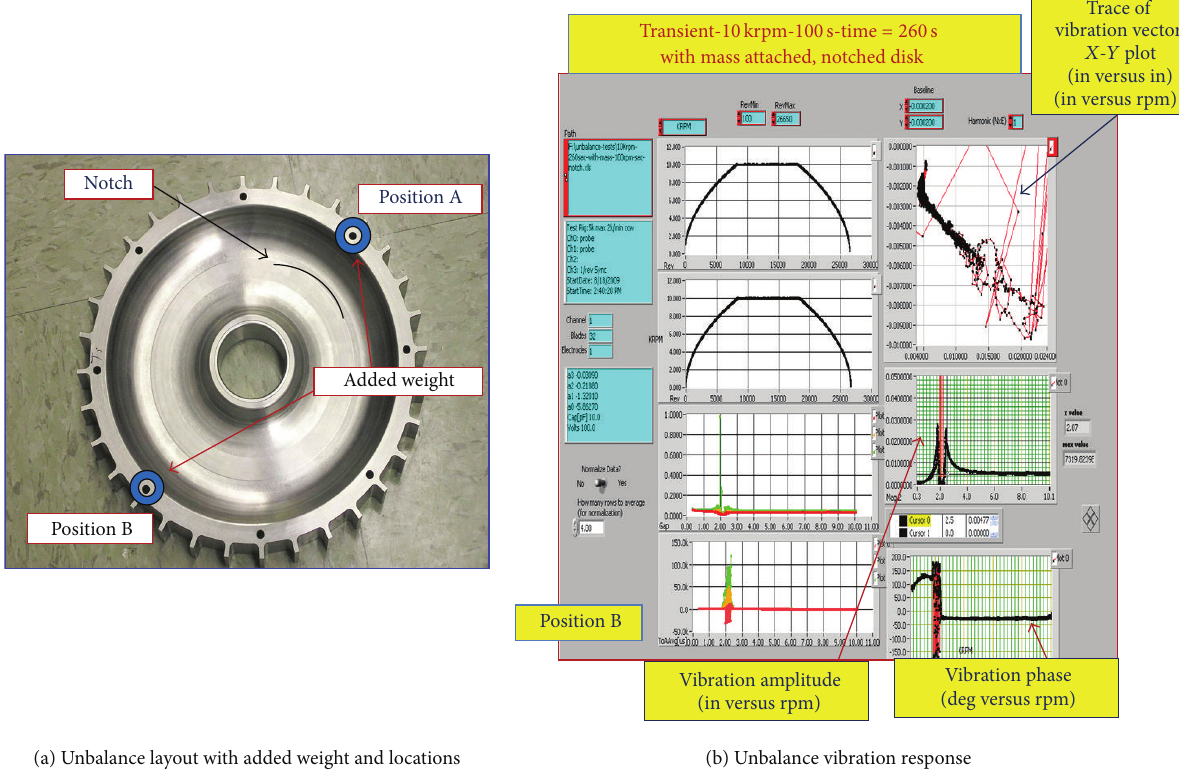
Figure 8: Tip clearance variation with blade numbers and simulated rotor unbalance